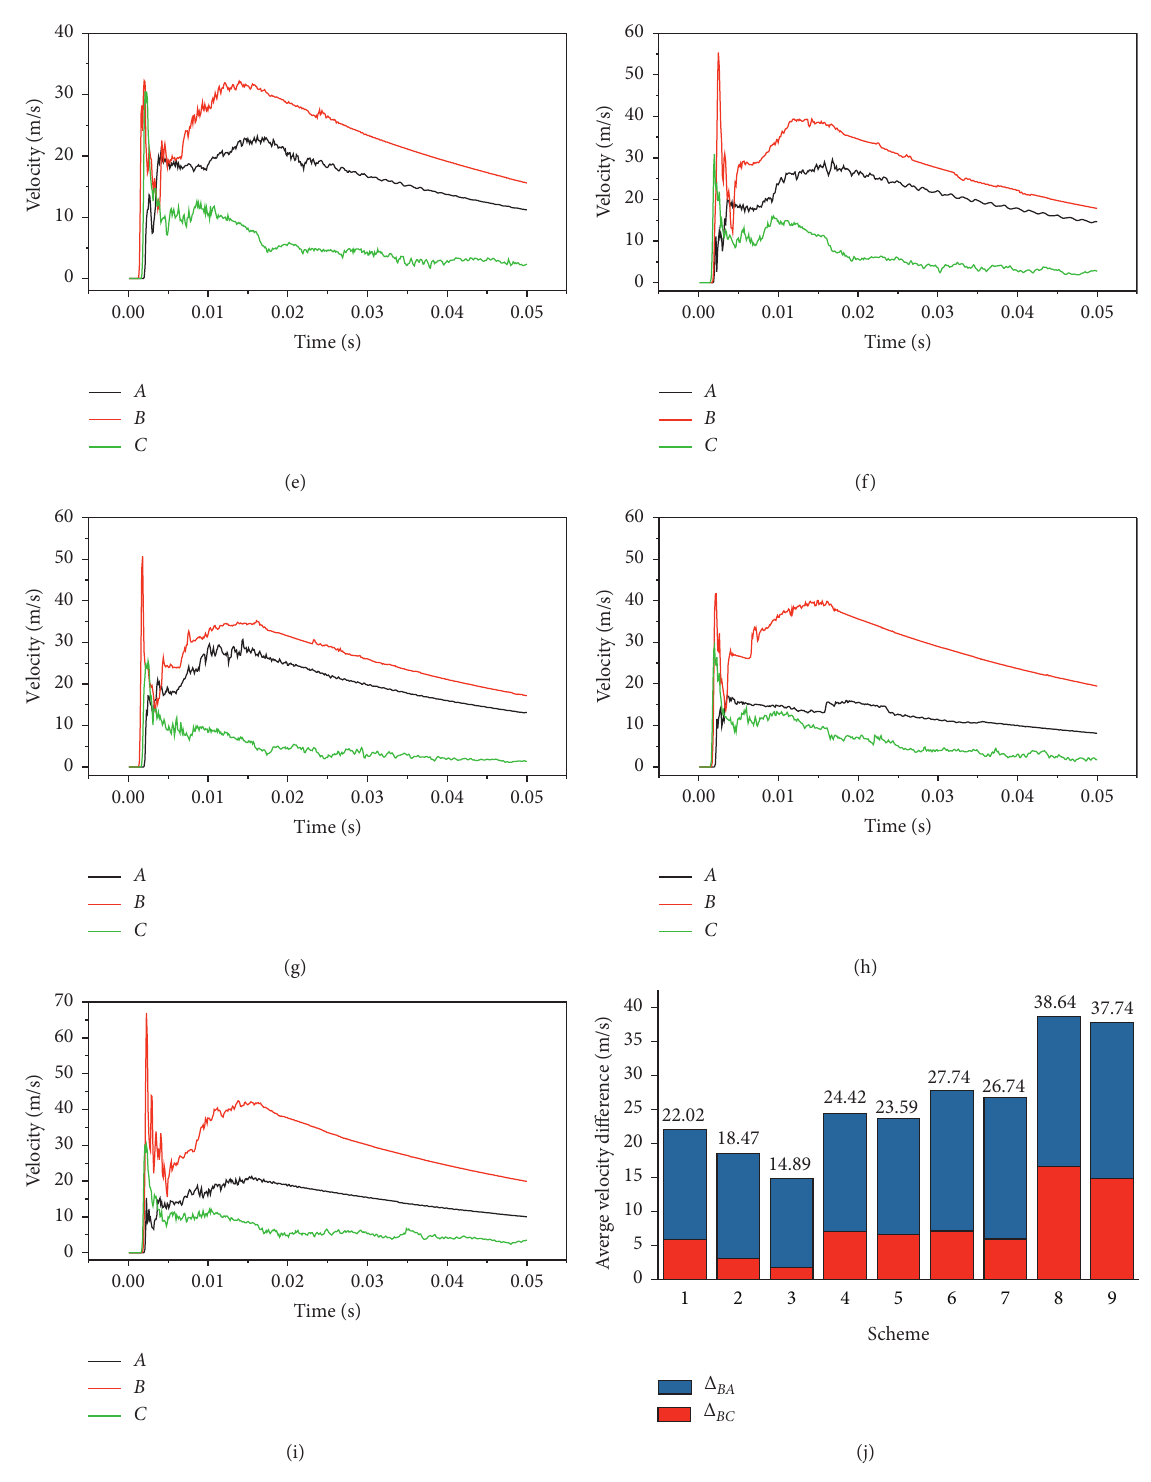
Figure 6: (a–i) Velocity monitoring curve under 9 schemes. (j) Statistics of average velocity differences under 9 schemes. Velocity monitoring curves of (a) scheme 1; (b) scheme 2; (c) scheme 3; (d) scheme 4; (e) scheme 5; (f) scheme 6; (g) scheme 7; (h) scheme 8; and (i) scheme 9. (j) Statistics of average velocity